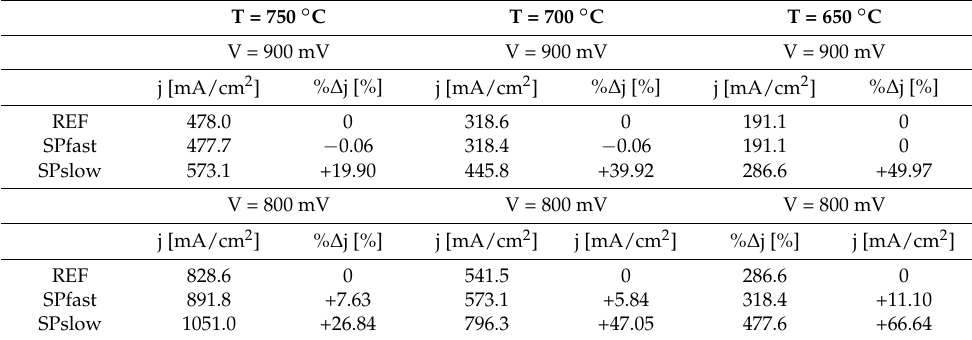
Current densities values obtained at 900 mV and 800 mV for all the considered working